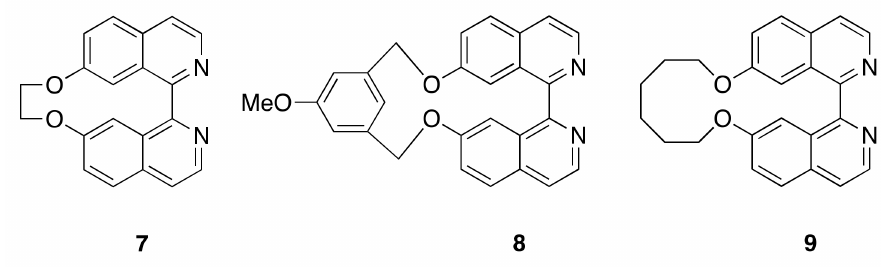
Figure 5. Macrocyclic ligands incorporating 1,1 (cid:48) -biisoquinoline metal-binding